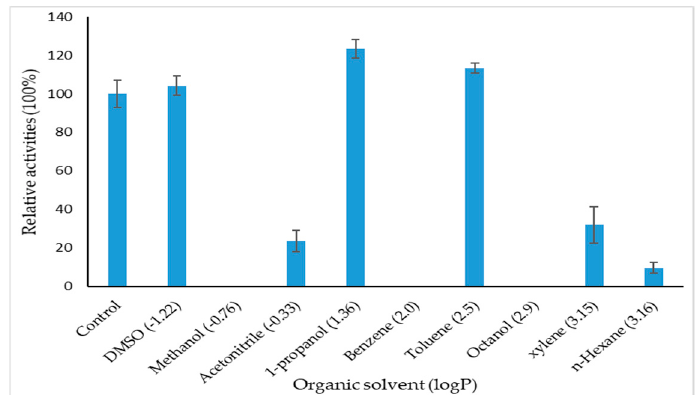
Figure 8. Effect of various organic solvents on the activity of purified GlaEst12-like esterase. The relative activity of the unincubated enzyme without organic solvent (control) was taken 100%. The log P is the logarithm of the partition coefficient, P, of the solvent between n-octanol and water, and is used as a quantitative measure of the polarity. Error bar represents standard deviation ( n =3).